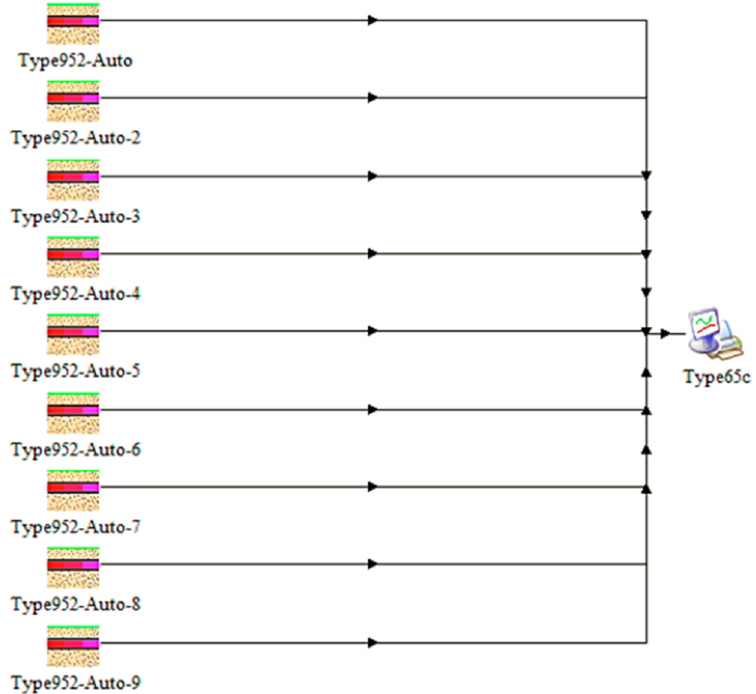
Figure 5. The scheme of the geothermal heat exchanger simulator builds on the TRNSyS 2017soft- ware.